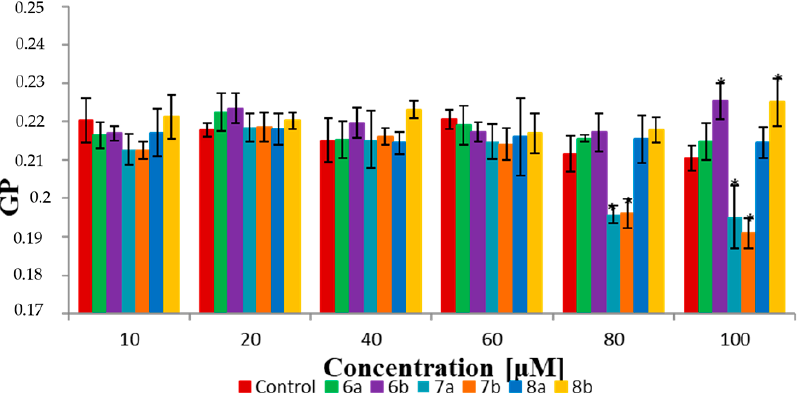
Figure 3. Values of generalized polarization (GP) of Laurdan probe for the RBCMs (control) and RBCMs with addition of compounds 6a , b , 7a , b , 8a , b at 37 °C. Values are mean ± SEM. Means labeled with asterisk (*) are significantly ( p ˂ 0.05) different from control.